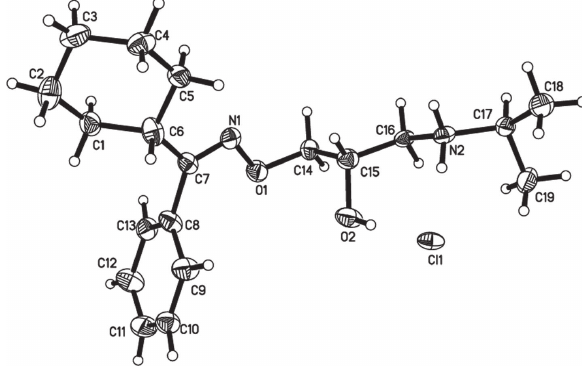
Table 1: Data collection and handling.